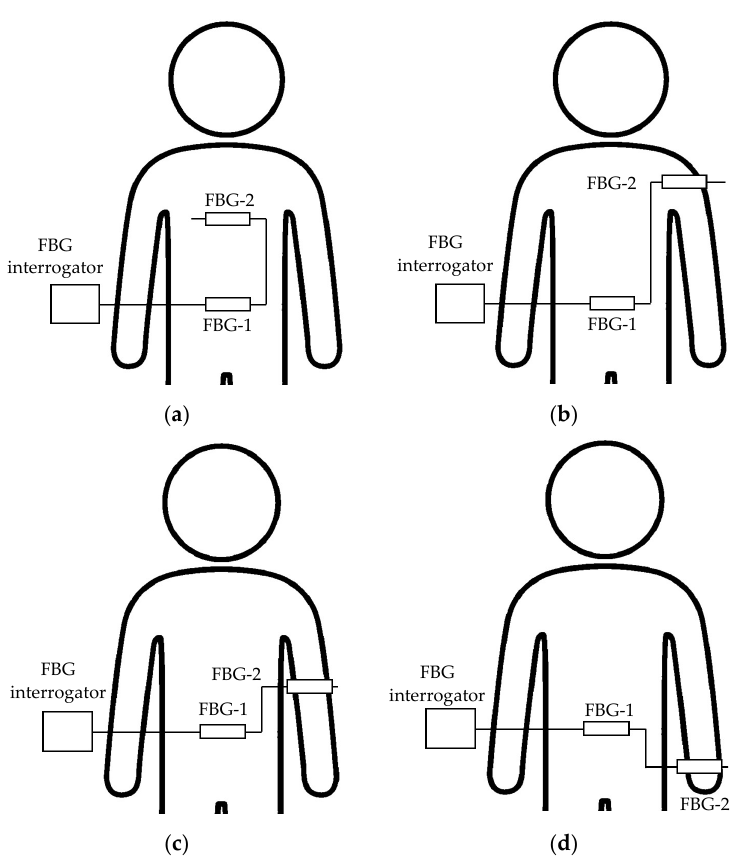
Figure 6. Image of the installation parts of each FBG sensor in the measurement experiment of the strain propagation range due to respiration to each living body part. ( a ): Abdomen and Chest, ( b ): Abdomen and Shoulder, ( c ): Abdomen and Elbow, ( d ): Abdomen and Wrist. Top peaks and bottom peaks were detected from the signal waveforms measured at each part, as with Figure 5. From these values, the average top peak value (Ave. Top peak), average bottom peak value (Ave. Bottom peak) and Longest amplitude value (Longest) were calculated. The ratio was calculated from the longest amplitude value of the abdomen measured at the same time as the longest amplitude value calculated for the chest, shoulders, elbows, and wrists (Longest amplitude value in abdomen/Longest amplitude in each part). When this ratio is smaller, it shows that the strain measured at each part is larger against the strain measured at the abdomen. When the ratio of the longest amplitude value to the abdomen measured at each part was smaller than the ratio of the longest amplitude value during breathing and apnea in Section 2.2, it was judged that respiratory strain could be measured. In this case, the time interval of the top peak of the signal measured at each part was detected, and this was defined as each respiratory time. The time interval of the top peak was also detected from the signal waveform of the abdomen measured at the same time. The measurement accuracy of the respiratory time calculation was verified from the correlation scatter plot of the respiratory time by each partial signal against the respiratory time by the abdomen signal. On the other hand, if the ratio of the longest amplitude value to the abdomen measured at each part was larger than the ratio of the longest amplitude value during breathing and apnea, respiratory strain was not measured. In this case, this ratio indicates that only strains smaller than the amplitude